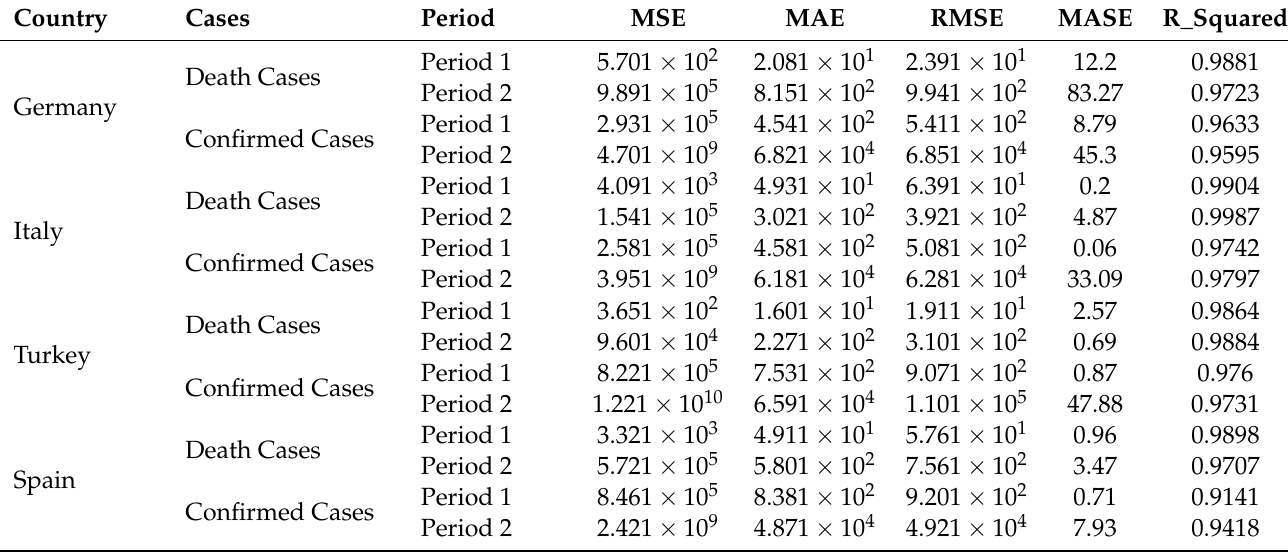
Table 2. COVID-19 spread forecasting results in countries with double spread wave based statistical evaluation criteria.